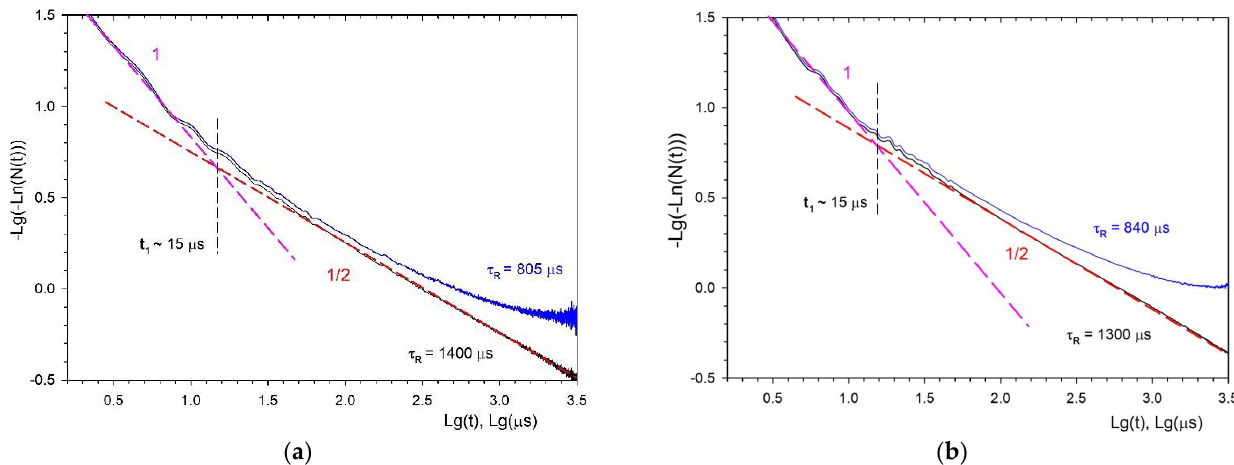
Figure 8. Fluorescence impurity quenching kinetics N ( t ) = I meas ( t ) / exp ( − t / τ R ) (black curves) from the 4 F 3/2 level of the Nd 3+ ion in NPs of type I ( a ) and type II ( b ) of an aqueous colloidal solution of 0.1 at.% Nd 3+ : LaF 3 NPs at τ R = 1400 µ s for NPs of type I and at τ R = 1300 µ s for NPs of type II. The blue curve is N ( t ) when trying to approximate the late stage of luminescence decay kinetics I meas ( t ) by an exponential function exp ( − t / τ R ) at ( a ) τ R = 805 µ s for NPs of type I and ( b ) at τ R = 840 µ s for NPs of type II. Red dashed lines are Förster kinetics exp and exp . The magenta dashed lines are the ordered decay stage exp ( − W ord t )